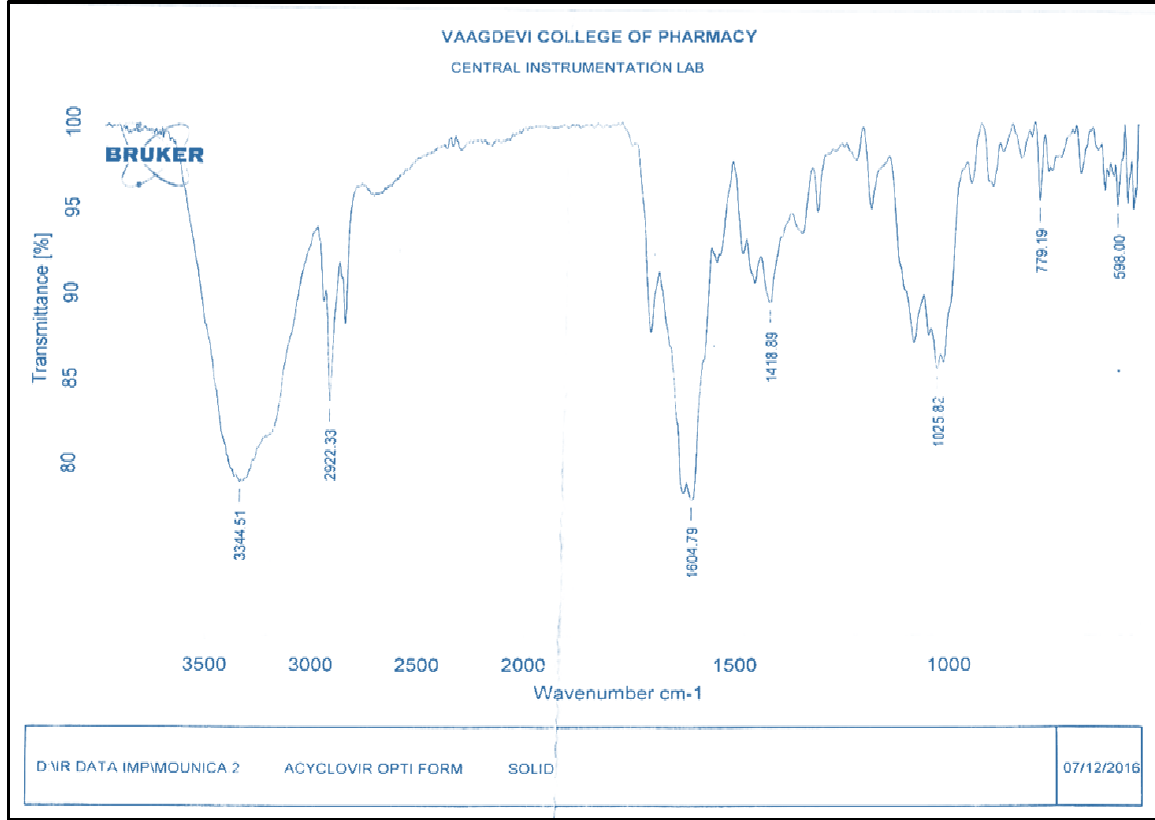
Figure 3. FTIR spectra of pure drug and microspheres The surface morphology of